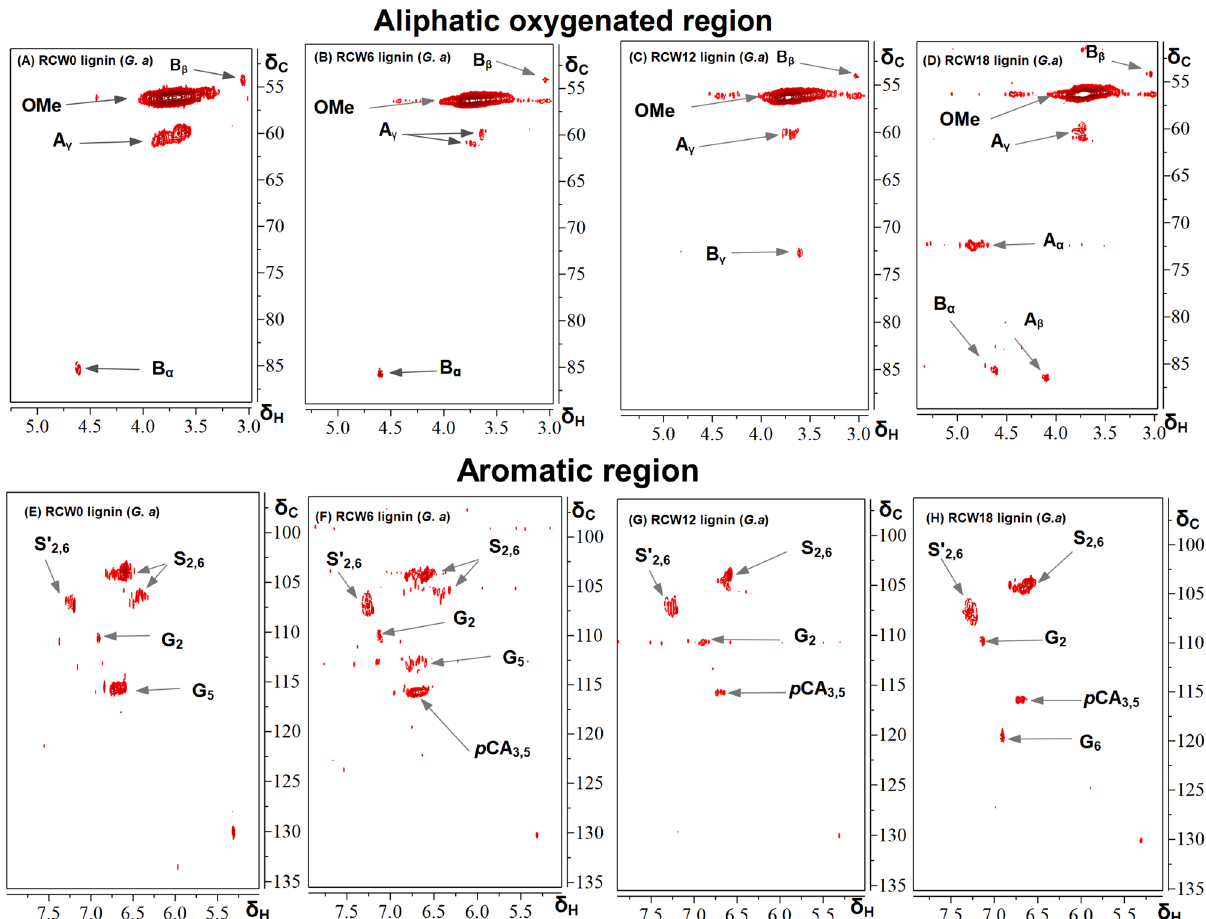
Figure 4. The 2D HSQC NMR spectra of RCW lignin from G. arborea ( A – H ). ( A – D ) Side chain (δC/δH 50–90/2.5–5.8) and ( E – H ) aromatic (δC/δH 90–120/5.5–8.0) regions in the 2D HSQC NMR spectra. G. a: Gmelina arborea , RCW0, RCW6, RCW12 and RCW18: RCW after 0, 6, 12 and 18 months of decomposition in soils, solv lignins from the RCW of G. arborea and S. latifolius , respectively. The assignments of cross-signals that are related to the structural units and interunit bonds in the study lignins are listed in Table S.1 and are based upon data that have been taken from the literature 2,19,37,60 . The aliphatic oxygenated region of the spectra (Figs. 4, 5, top panel) have yielded useful information about the types of interunit linkages in the lignins under study. The cor- relation peaks (δ C /δ H ) from methoxy (MeO) and β-O-4 ′ aryl ethers (A) were the most prominent in the HSQC spectra of the lignins of both species. It should be noted that this result confirms that the major interunit moiety of lignins does survive the decomposition process (Table 6). It is remarkable that the β-O-4 ′ moiety (Fig. 6), which could be regarded as the hallmark of lignin identity, is preserved. HSQC spectra revealed the presence of other characteristic signals which correspond to C α -H α (71.8/4.83 ppm), C β -H β (83.9/4.28 ppm), and C γ -H γ (60.2/3.66 ppm) correlations for the β-O-4 ′ substructures (A), C β -H β (86.9/4.08 ppm) correlations in γ-acylated β-O-4 ′ linkage. These β-O-4 ′ substrcutures were less prominent in the lignins from RCW corresponding to longer residence in soils. In addition, other correlation peaks are visible in the spectra including signals for β-β ′ resinol (B) in all lignin samples and β-5 ′ phenylcoumaran (C), which is only present in the organosolv lignin from the RCW of S. latifolius . The presence of the latter confirms the importance of guaiacyl units for this lignin; this component has been determined for the lignin sample that was isolated from the initial RCW (time zero). In the aromatic unsaturated region of the HSQC spectra (Figs. 4, 5, bottom panel), the main correlation peaks that were found correspond to the aromatic rings of different lignin units (S, G), and to p -hydroxycinnamates C /δ H 104.2/6.61, 110.7/6.98, 115.5/6.67, 119.9/6.91 ppm corresponding to S 2,6 , G 2 , G 5 and G 6 , respectively. Also, the signal corresponding to Cα-oxidized S-units (S ′ 2,6 ) at δ C /δ H 107.4/7.28 ppm was only observed in lignins from G. arborea samples. All study lignins were determined to contain a signal of p -coumarate ( p CA), which was confirmed by important correlation (δ C /δ H ) at 115.7/6.69 ppm ( p CA 3,5 ), while signals corresponding to p -coumarate in C 7 –H 7 ( p CA 7 ) (137.3/7.87 ppm) and p CA2,6 (124.7/7.44 ppm) were only found in the spectral data for lignins from S. latifolius .